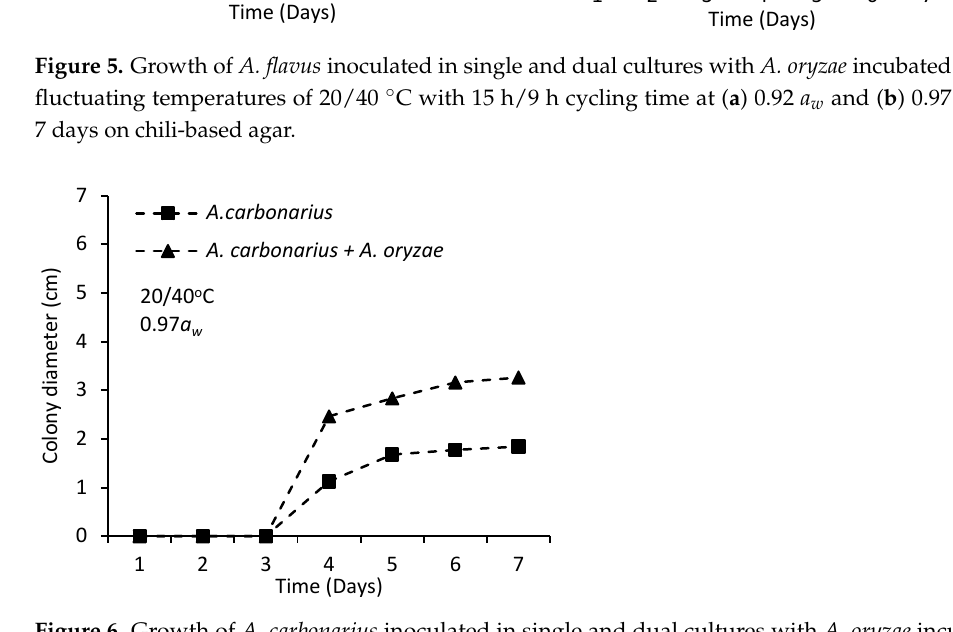
Table 4. AFB 1 and OTA production by A. flavus and A. carbonarius on single and dual cultures with A. oryzae on chili-based agar with 0.92 a w and 0.97 a w for 4 and 7 days at 20/40 °C.